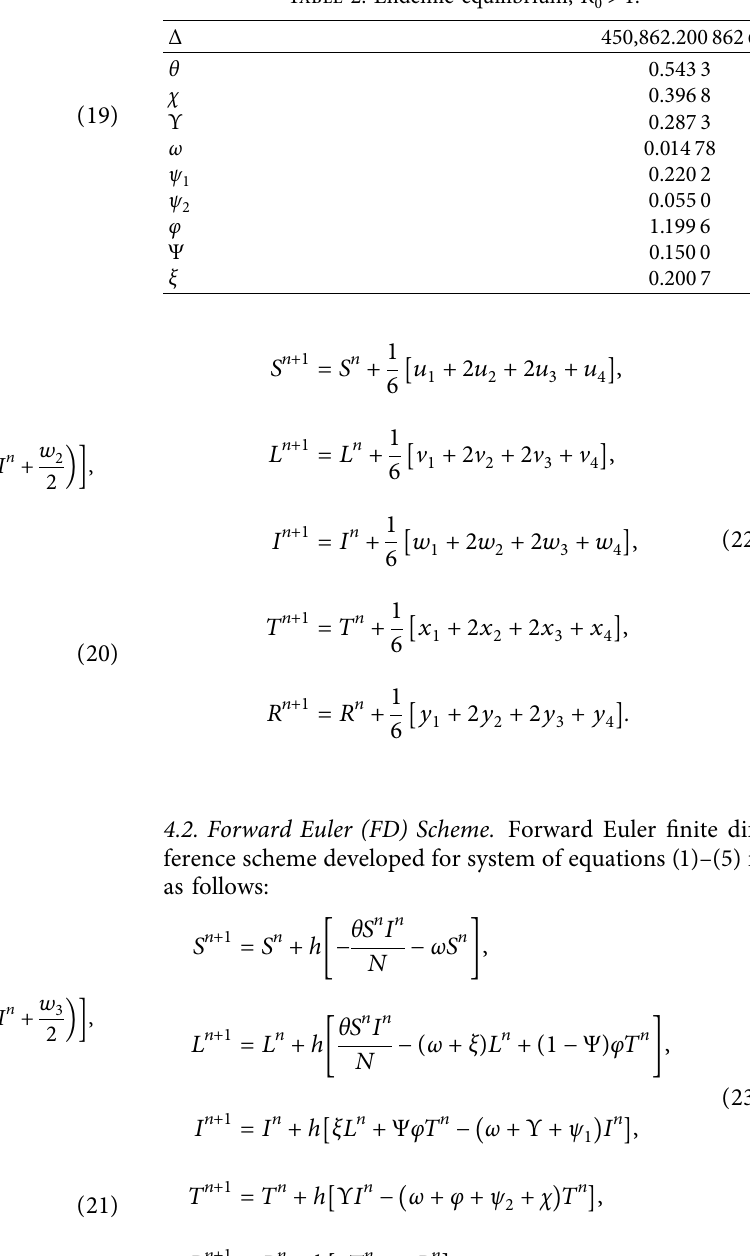
Table 2: Endemic equilibrium, R